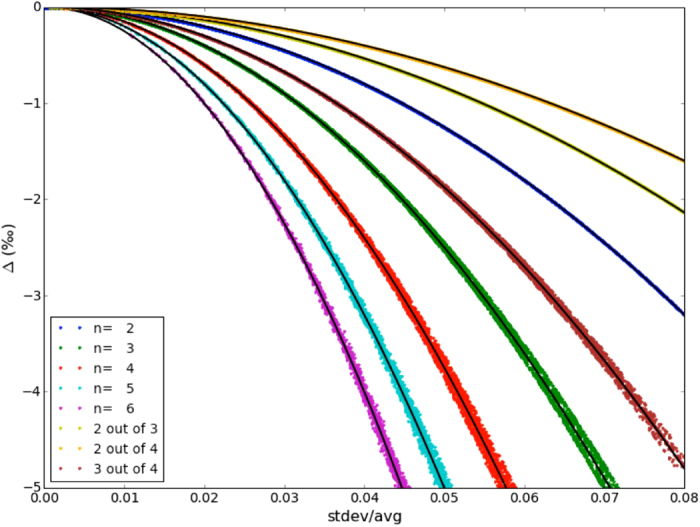
Relation between the apparent statistical heavy isotope clumping signal Δ and the relative standard deviation (stdev/average) of the involved indistinguishable atoms for randomly generated sets of isotope ratios.For each multi-isotope system, the points fall close to well-defined analytical curves (black lines) of the general form . Note that the Δ values are given in ‰, i.e. the coefficients of the quadratic term in the fit have to be divided by 1000. As an example, for 2-atomic systems (n = m = 2) the fit is Δm out of n = −500‰.